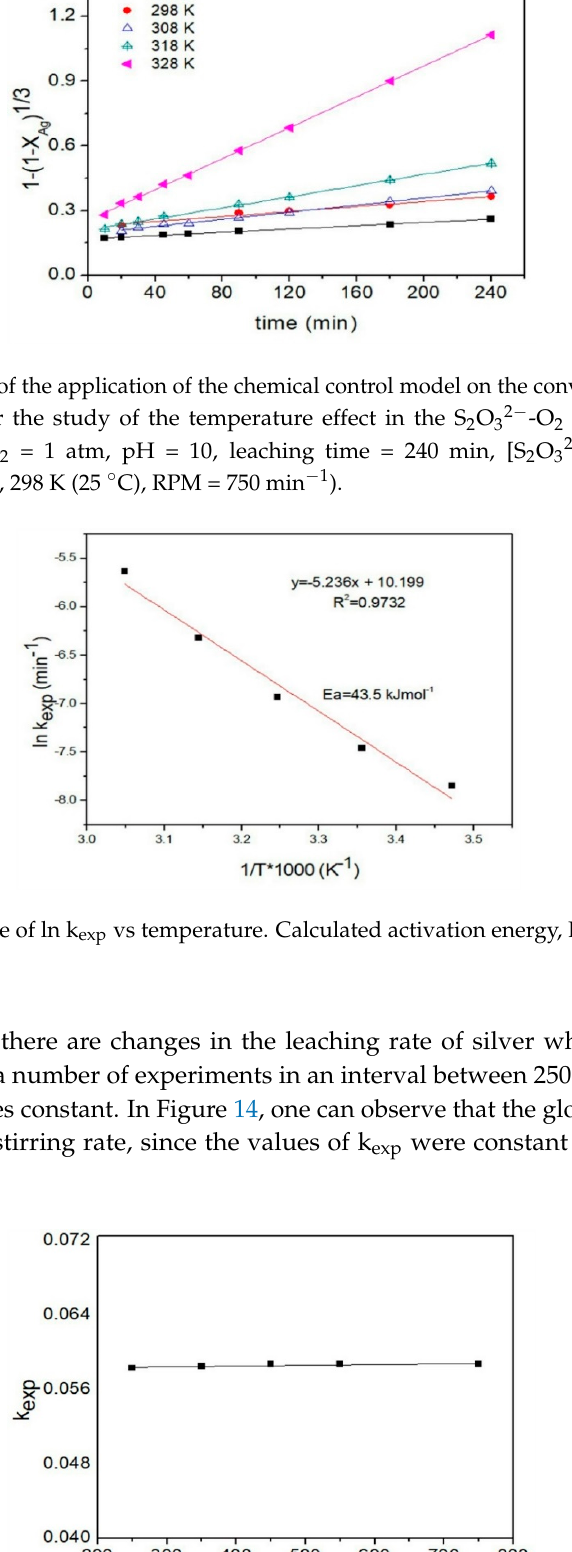
Figure 14. Dependence of k exp in function of stirring rate.